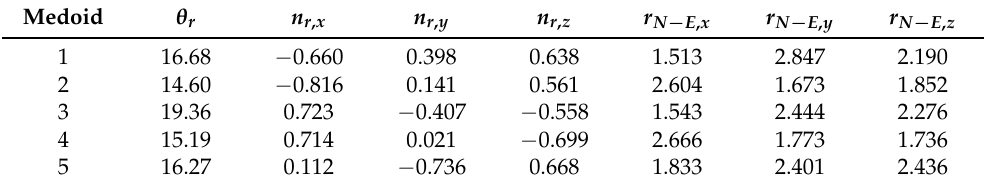
Table 1. Clustering feature values of the five cluster medoids from TCNE: π :1ClN trajectory. θ r : rotation angle (angle between versors normal to the two molecular planes, degrees), ˆ n r : rotation axis (versor normal to the former ones), (cid:126) r N − E : relative position vector (between 1ClN and TCNE geometric centers). Vector quantities are given as cartesian components (Å) in a fixed frame of